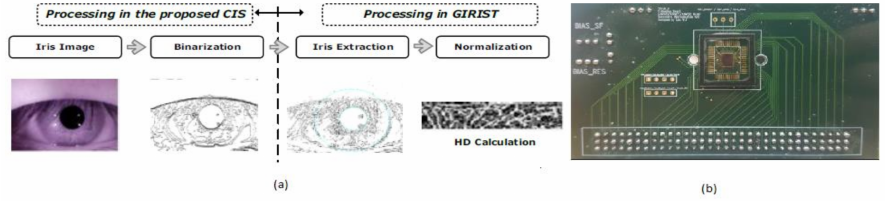
Figure 28. ( a ) Iris recognition process with proposed CIS. ( b ) CIS chip on printed circuit board (PCB) [34].